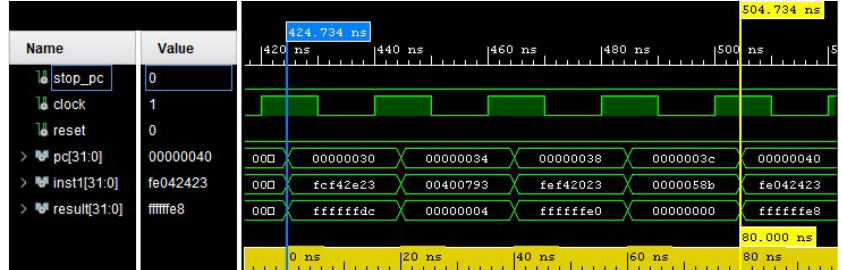
Figure 9. Waveform of the example’s result on a non-modified processor.